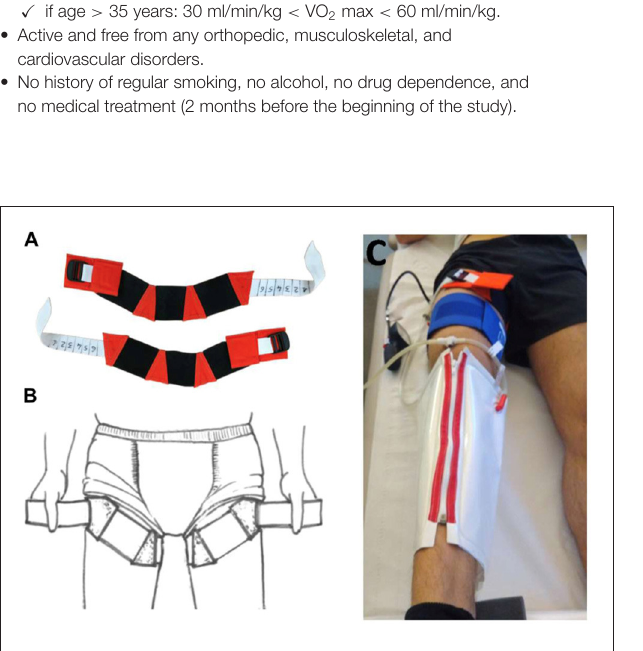
X The retinal map corresponded to the average macular thickness ( Figure 4A ) X Ganglion cell complex (GCC) thickness was divided into three measurements: average, superior- and inferior-retina ( Figure 4B ) X Optic nerve head (ONH) thickness was divided into four quadrants: temporal, nasal, superior, and inferior ( Figure 4C ) Retinal map and GCC images were acquired on a 6 × 6 mm mapping square centered on the fovea, with 5 to 10 µ m resolution horizontal B-scans. ONH and RNFLT measures were acquired with horizontal B-scans centered on the optic disc. Segmentation of the internal limiting membrane and the Bruch membrane opening were verified